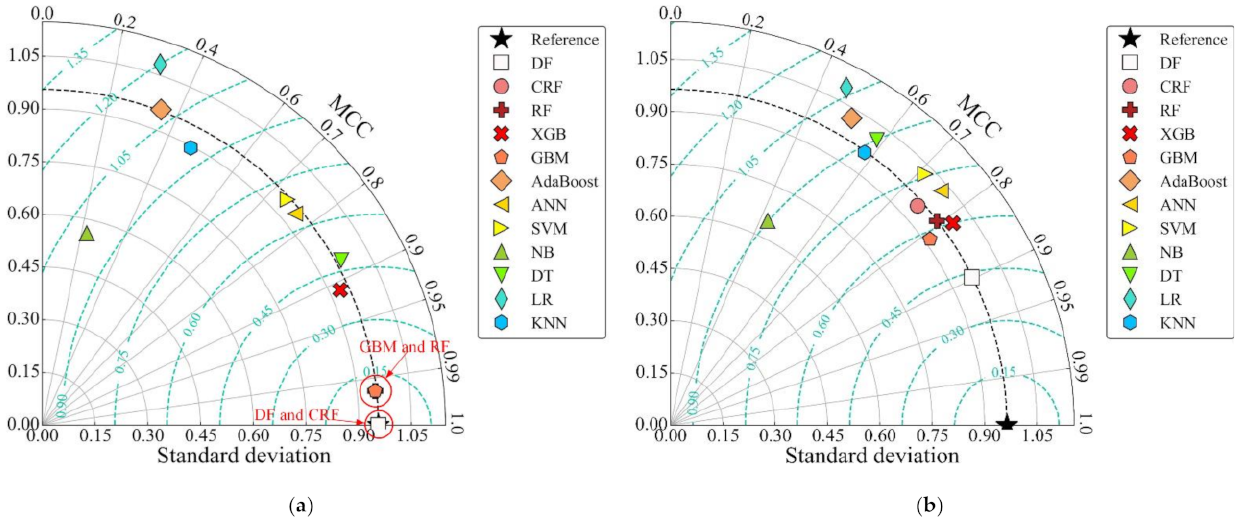
Figure 11. Taylor diagrams for comparing the performance of developed models. ( a ) Training results; ( b ) Testing results.